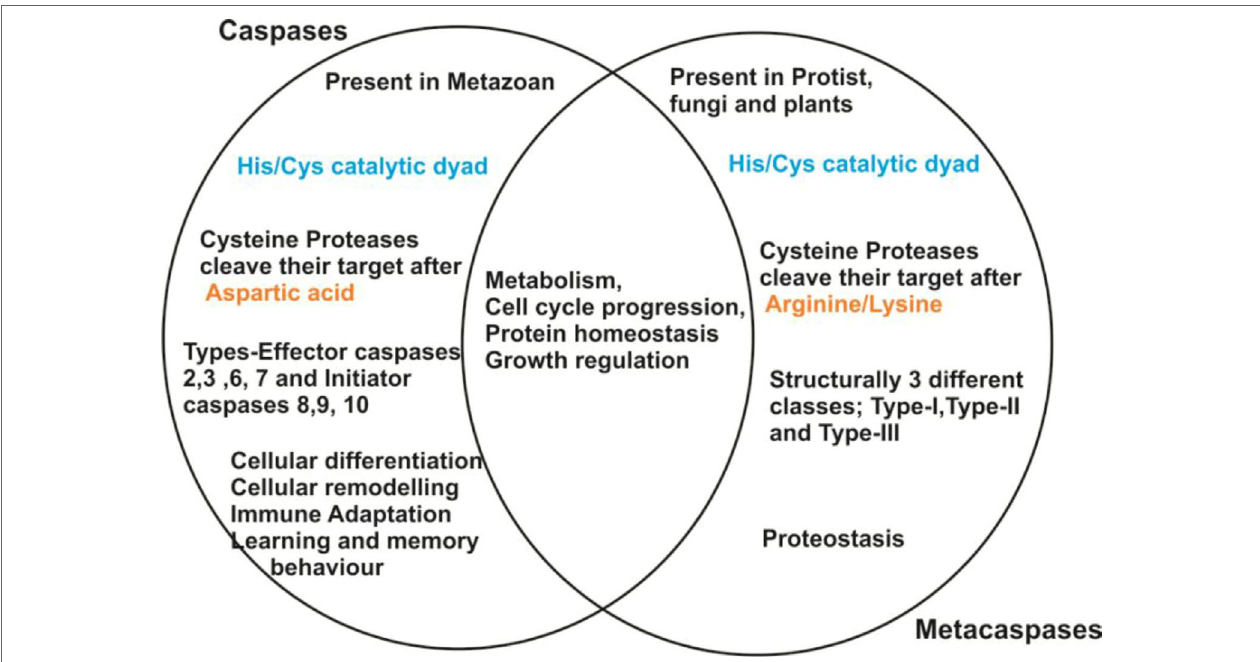
FIGURE 1 | Summarized pictorial representation showing the key properties of caspases and